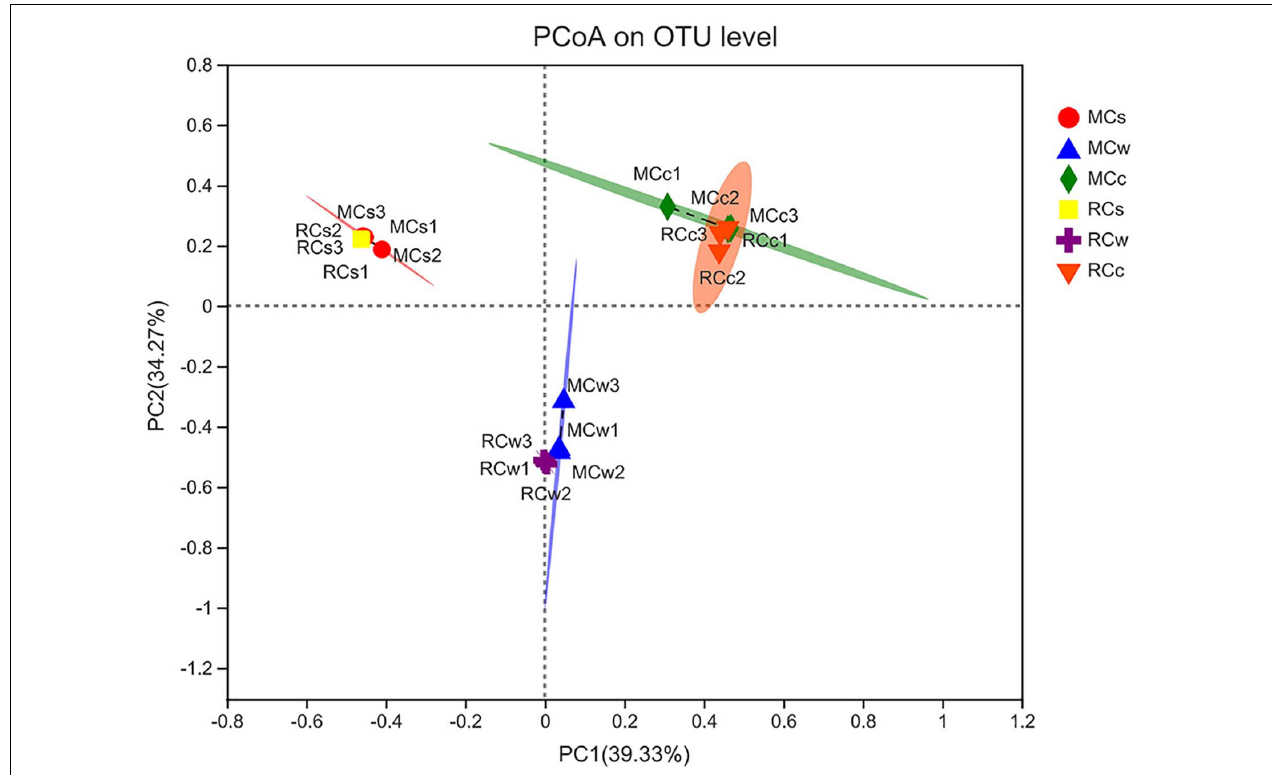
FIGURE 4 | Principal co-ordinates analysis (PCoA) of the bacterial community at the level of operational taxonomic units (OTUs).